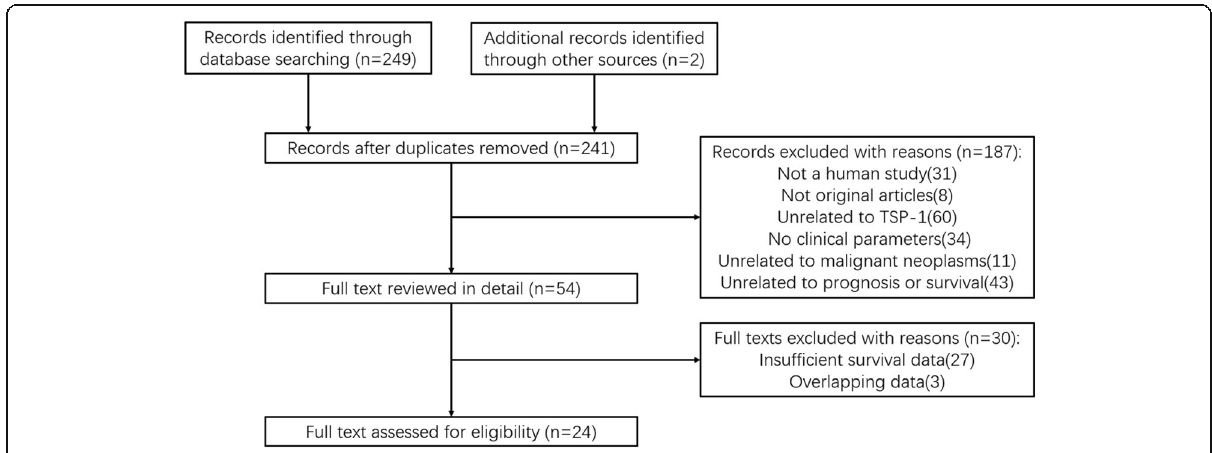
Fig. 1 Selection process of studies for